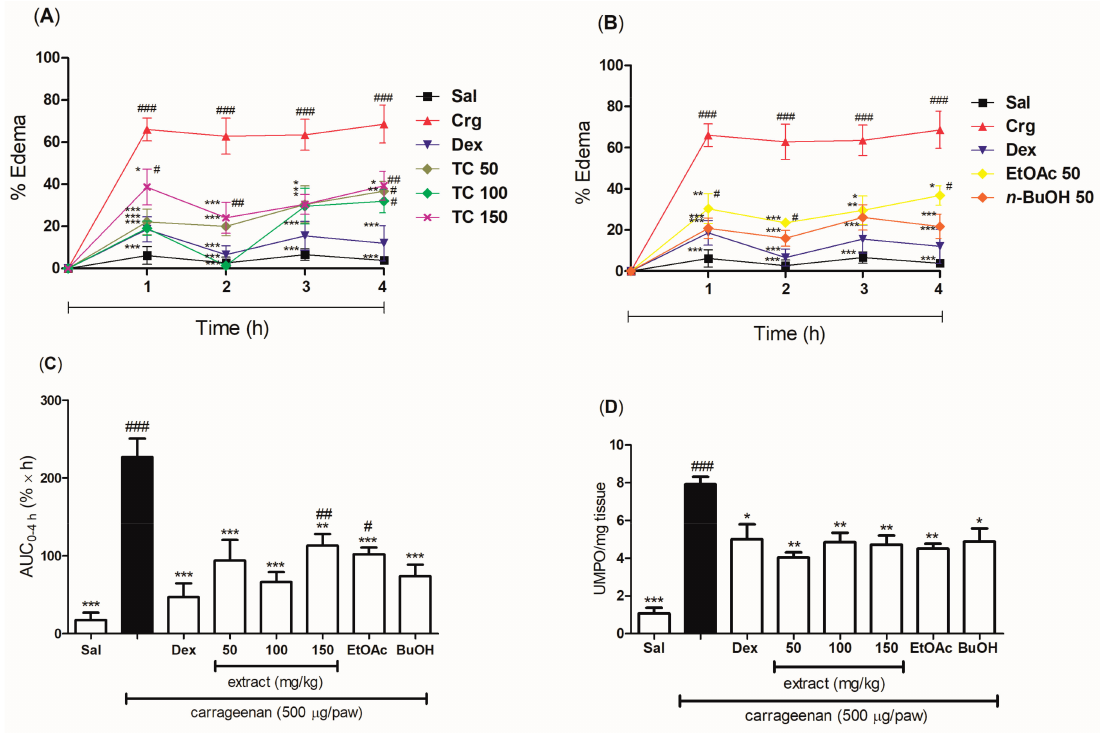
Figure 3. Evaluation of the anti-inflammatory effect of the pretreatment with the hydroethanolic extract and the ethyl acetate (EtOAc) and n -butanol (BuOH) fractions of T. catharinensis leaves in the carrageenan-induced paw edema model. BALB/c mice were treated orally with saline, the hydroethanolic extract at doses of 50, 100, or 150 mg/kg, the EtOAc and BuOH fractions at a dose of 50 mg/kg, and dexamethasone at 2 mg/kg. The edema was measured at different time points (1, 2, 3, and 4 h) after the administration of λ -carrageenan (500 µ g/paw). After 4 h, the paw was removed and the enzymatic activity was measured. One unit of myeloperoxidase (MPO) activity (UMPO) was defined as the degradation of one micromole of peroxide per minute. ( A ) Percentage of edema (0–4 h) in mice pretreated with the hydroethanolic extract; ( B ) Percentage of edema (0–4 h) in mice pretreated with the EtOAc and BuOH fractions; ( C ) Area under the curve (AUC) for the percentage of paw edema as a function of time (0–4 h) in mice pretreated with the hydroethanolic extract and fractions; ( D ) MPO activity in paw tissues of mice pretreated with the hydroethanolic extract and fractions. ### p < 0.001, ## p < 0.01, and # p < 0.05 compared with the group treated with saline; *** p < 0.001, ** p < 0.01 and * p < 0.05 compared with the carrageenan group. Sal: saline (0.9 mg/mL); Crg: carrageenan (500 µ g/paw); Dex: dexamethasone (2.0 mg/kg); TC 50: T. catharinensis extract (50 mg/kg); TC 100: T. catharinensis extract (100 mg/kg); TC 150: T. catharinensis extract (150 mg/kg); EtOAc 50: ethyl acetate fraction (50 mg/kg); BuOH 50: n -butanol fraction (50